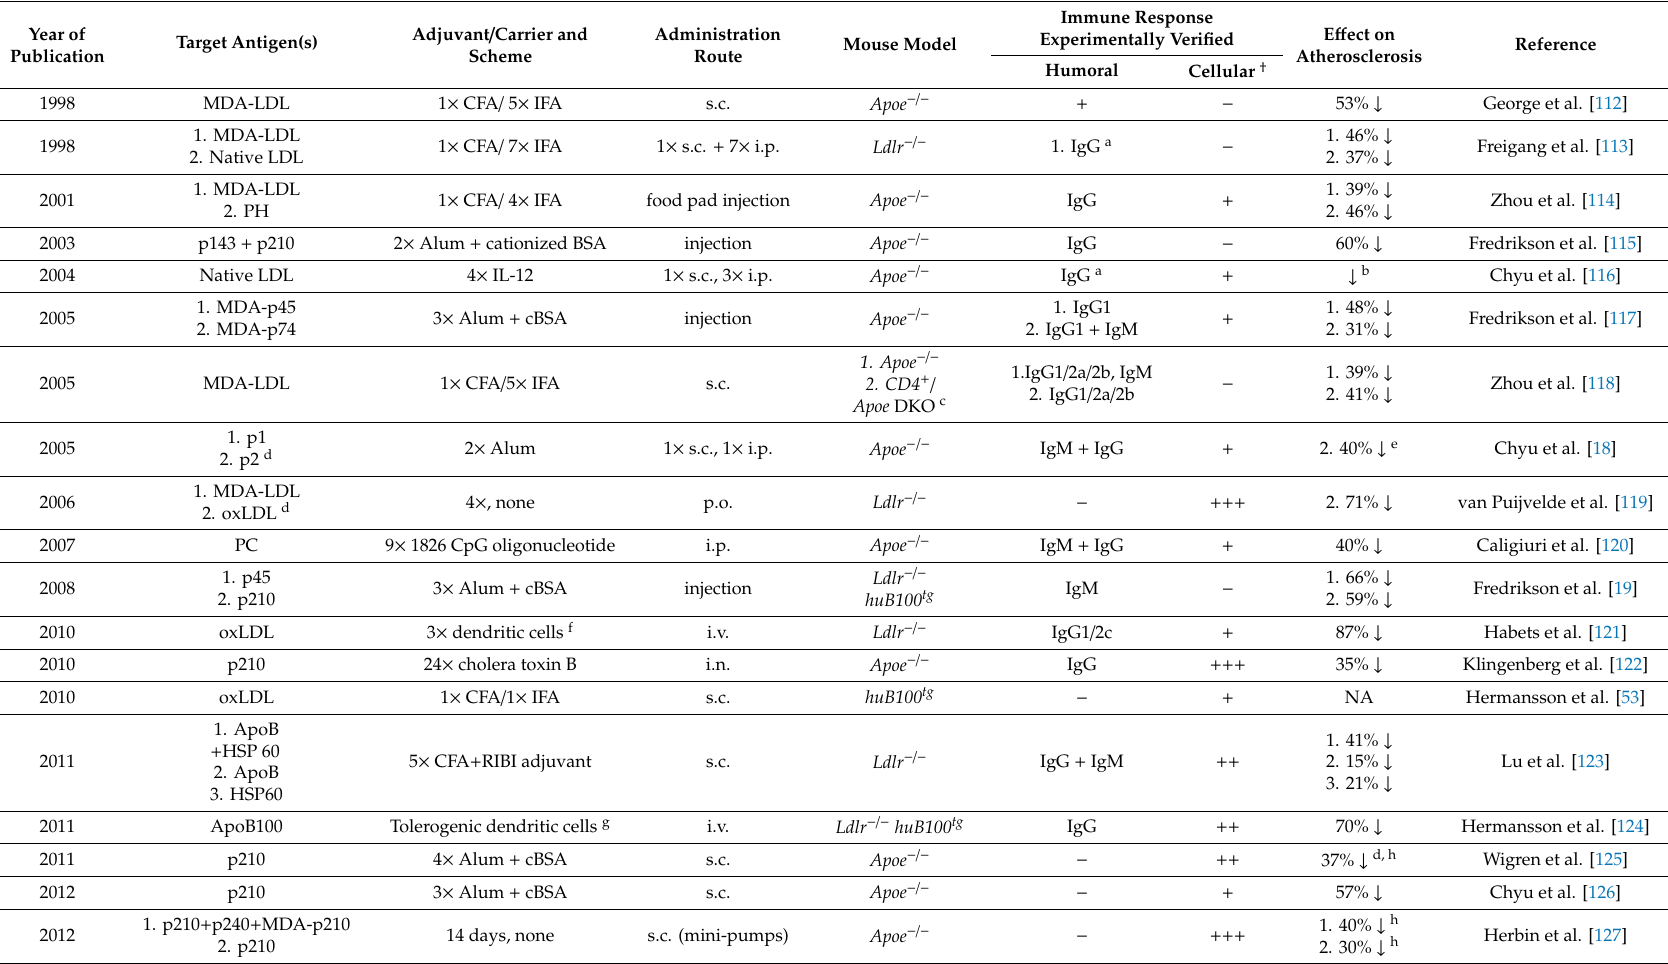
Table 2. Experimental studies investigating immunization against LDL-related antigens in